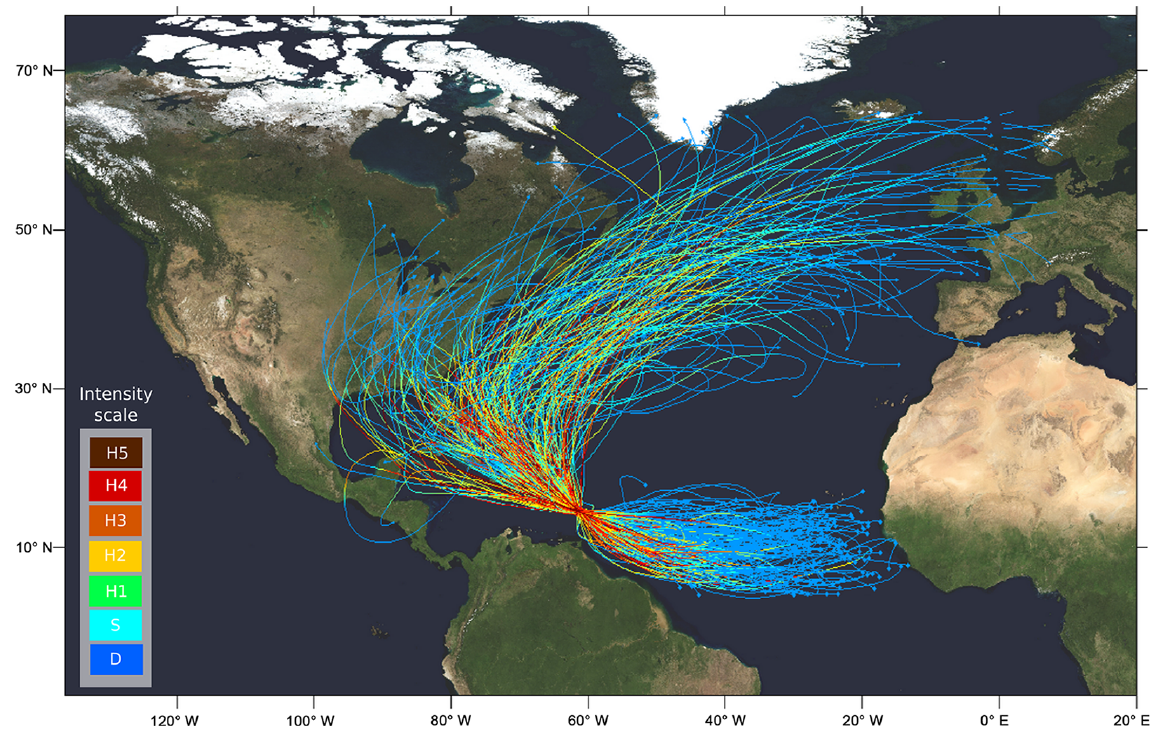
Figure 3. Examples of synthetic hurricanes generated for this study, using the statistical-numerical approach of Emanuel et al.